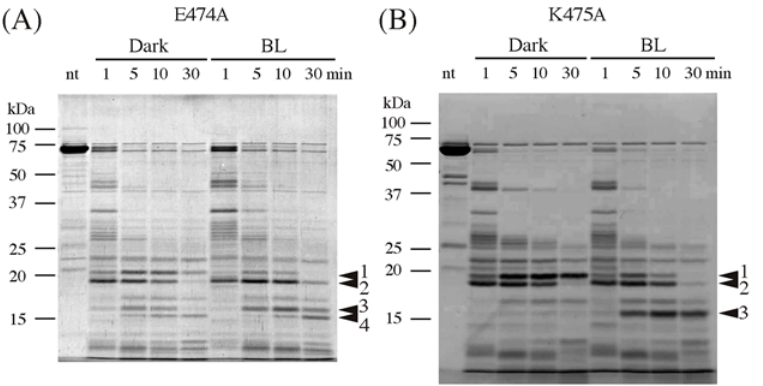
Fig 6. Peptide mapping of At phot1 LOV2-STK E474A, (A), and K475A, (B) by SDS-PAGE after trypsin digestion in the dark (D) or under BL irradiation (L). Time courses of the digestion are indicated. nt indicates the sample without the trypsin-treatment. The four arrowheads indicate the bands of major proteolytic